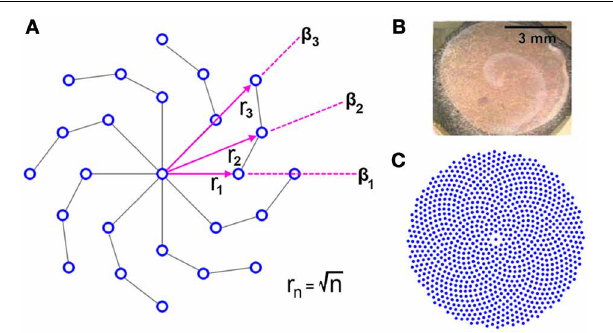
FIGURE 5 | (A) Generating uniform global and local neuron density in a radially symmetric distribution via an adaptive algorithm that varies the angular of new neurons β n such distance to the nearest neighbor is maximized results in a spiral structured disc. The disc is shown with ( (cid:2) = 8, N = 4). (B) Spiral propagating waves of neural activity on the chicken retina due to excitation. Image from (Yu et al., 2012). (C) The spiral structure at larger scales RPN disc with ( (cid:2) = 8, N =